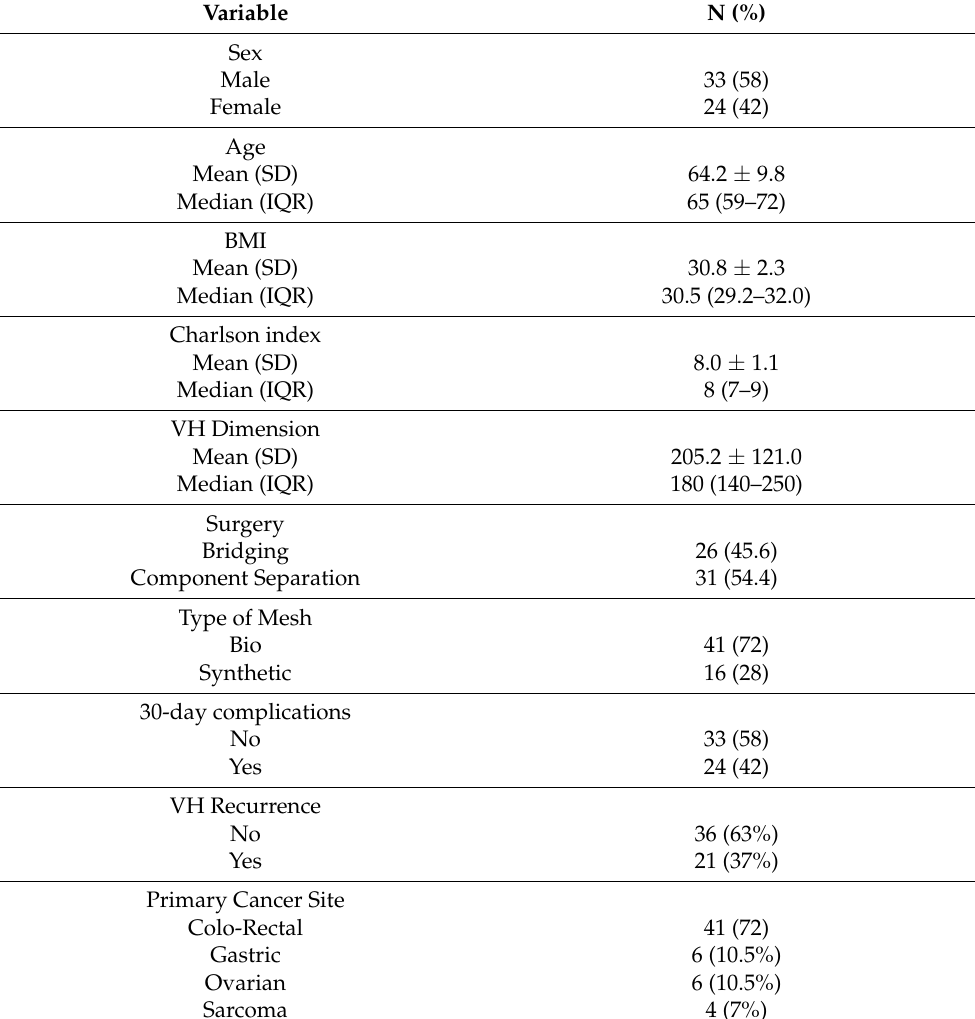
Table 1. Patient